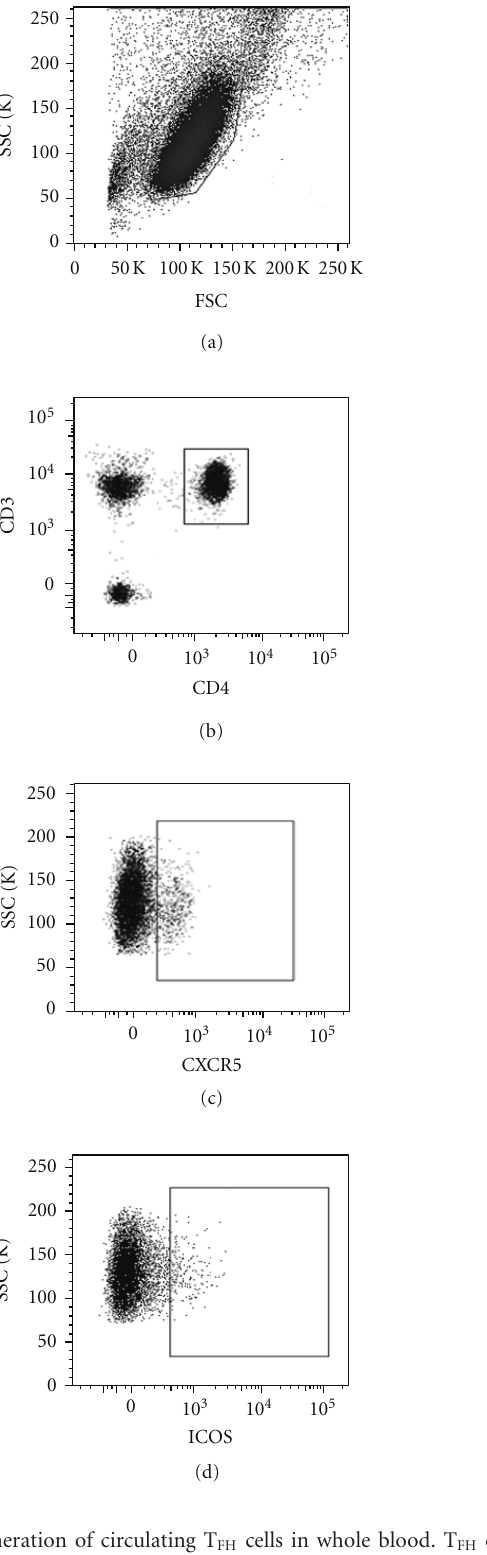
Figure 1: Enumeration of circulating T FH cells in whole blood. T FH cells were counted in whole blood using four di ff erent phenotypic definitions. (a)–(d) Representative gating strategy. (e) CD4 + /CXCR5 + ; (f) CD4 + /CD45RO + /CXCR5 + ; (g) CD4 + /CXCR5 + /PD-1 hi ; (h) CD4 + /CXCR5 + /ICOS hi . No di ff erences were detected between patients with RA and controls ( P ≥ 0 . 4 in all cases). Spots represent individual patients. Mean ± SEM are